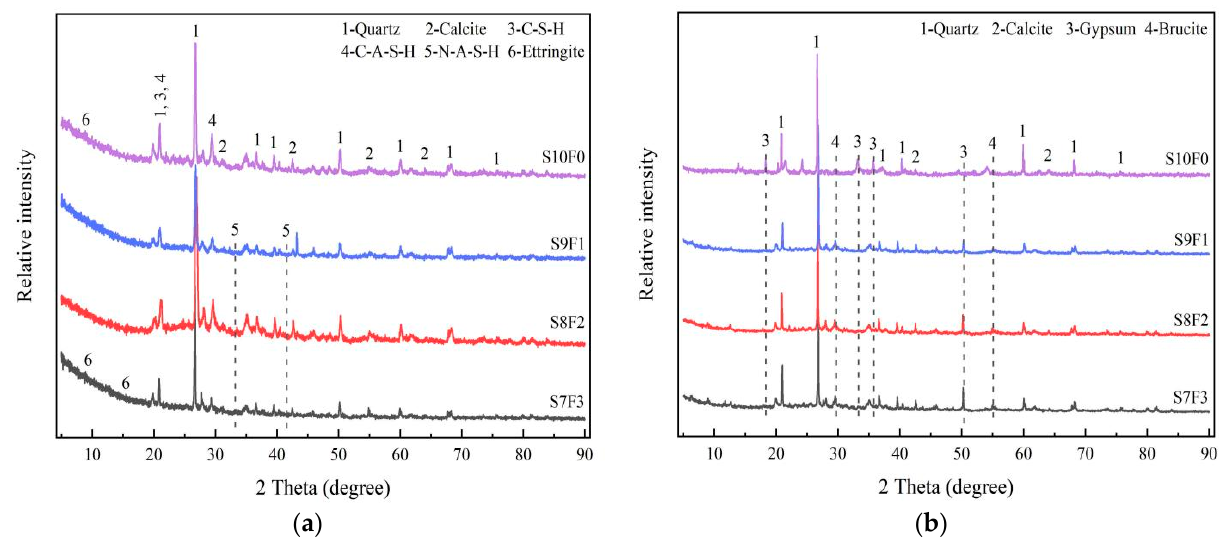
Figure 9. XRD analysis of SF-GSSS after 60 days immersion: ( a ) Na 2 SO 4 solution and ( b ) MgSO 4 solution.